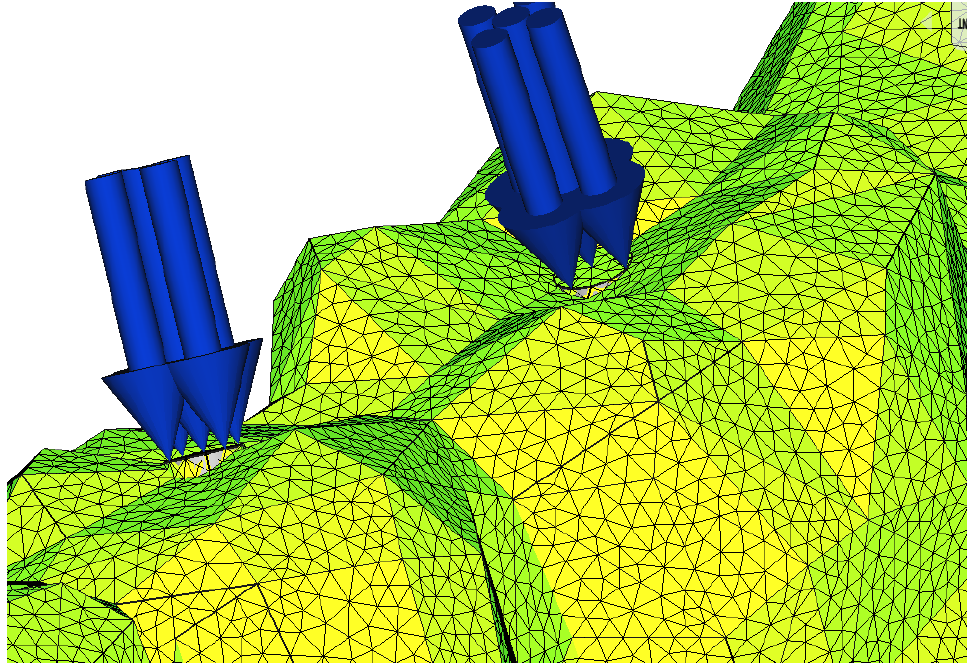
Figure 2. Occlusal loading on the axis of the teeth.